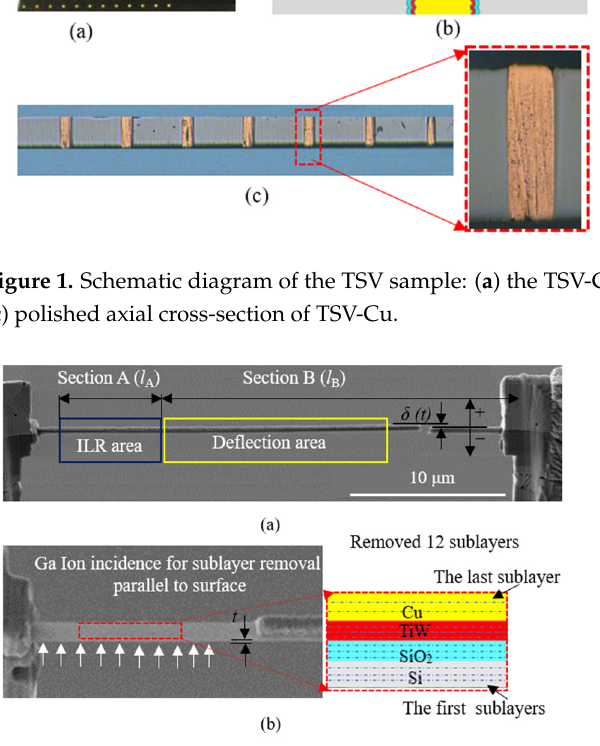
Table 1. Dimensions of the micro cantilever beam.